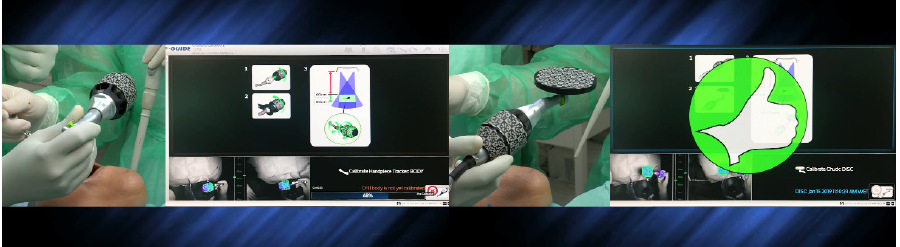
Figure 9. Calibration of the handpiece. The same procedure was performed for the chuck, probe tool, 5 TriStar screws, and the preparation drills.